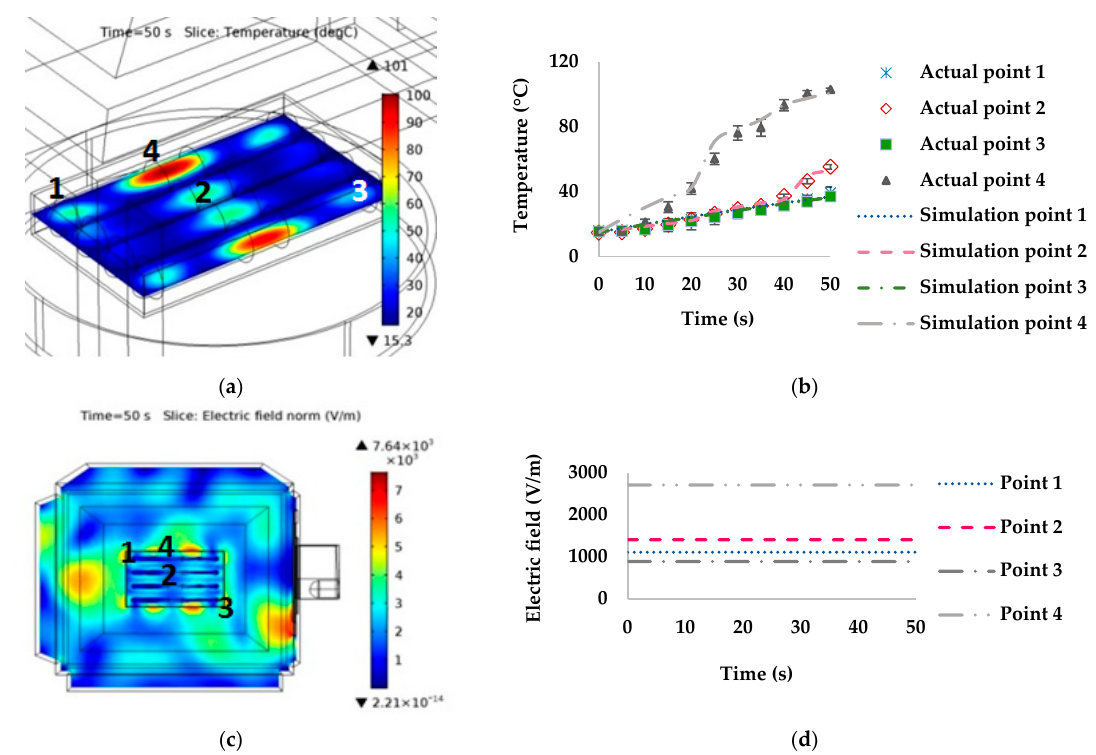
Figure 8. Effect of simulated stationary microwave on ( a ) thermal simulation, ( b ) temperature profile at points 1–4, ( c ) electric field, and ( d ) electric field profiles at points 1–4 of ready-to-eat sausage at 90° orientation to waveguide.